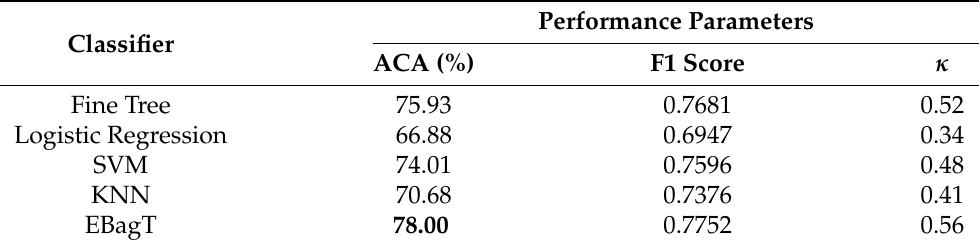
Table 12. Summary of performances obtained by various classifiers using features extracted from both EEG channels of 77 subjects with ten-fold CV strategy. The bold font style represents maximum